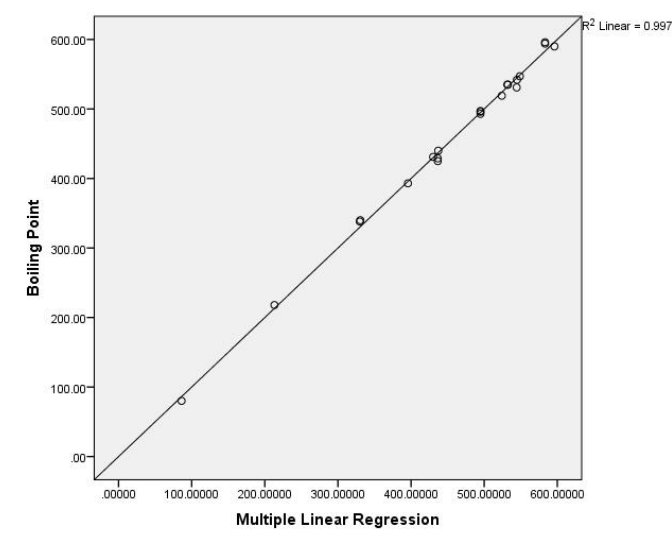
Figure 7. The multiple linear correlation for the boiling points for benzenoid hydrocarbons.